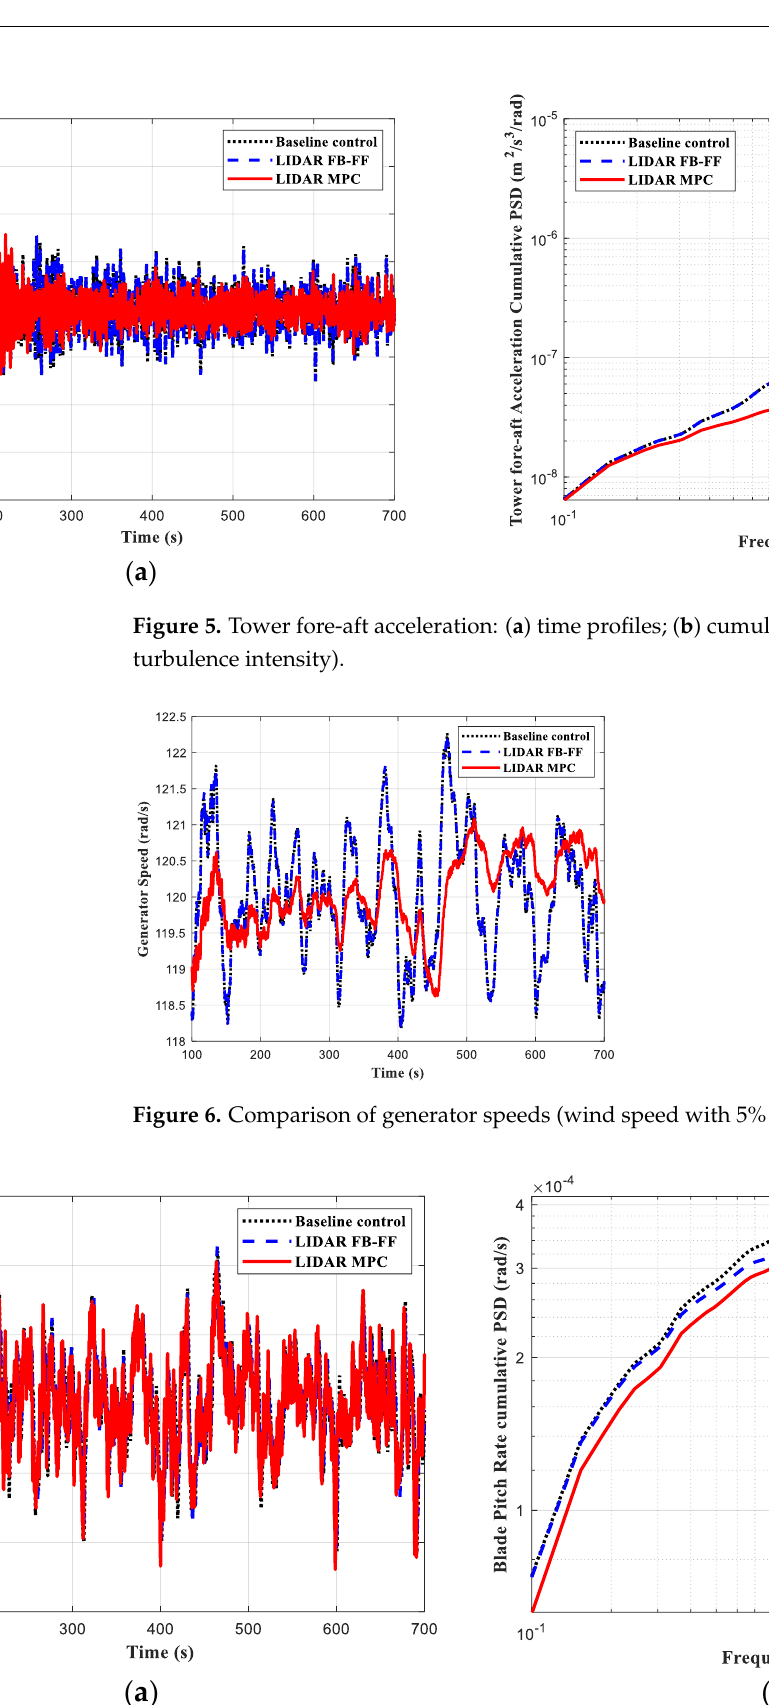
Figure 7. Blade pitch rate: ( a ) time profiles; ( b ) cumulative PSD (wind speed with 5% turbulence intensity).